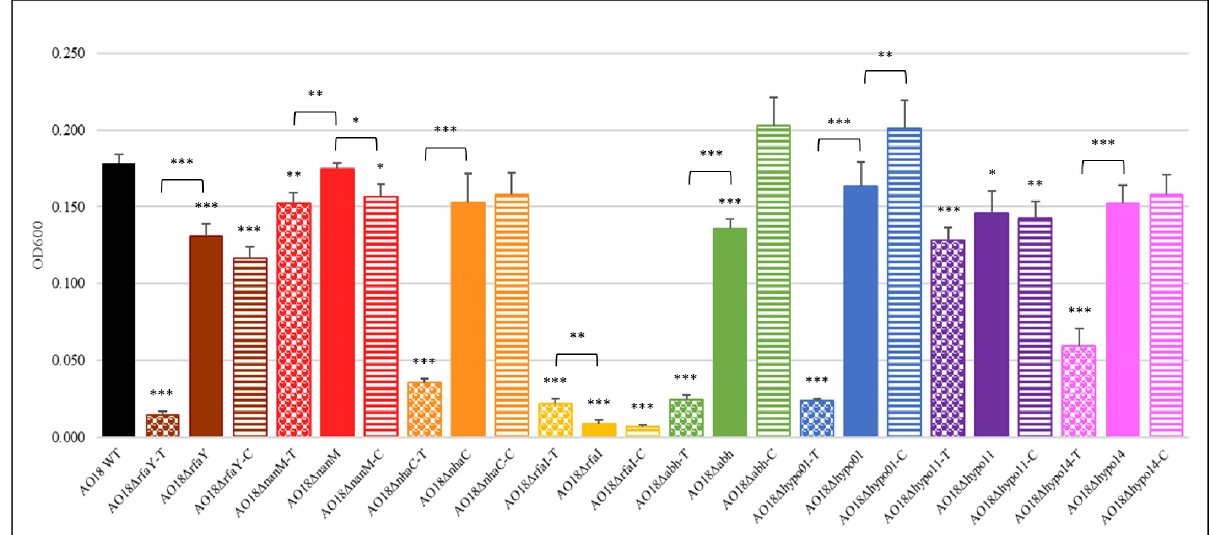
Fig 3. Biofilm production of all the strains tested. The biofilm formation ability of the transposon mutants, isogenic mutants, and complemented mutants were compared to that of the APEC O18 wild type (AO18 WT). Each test strain was grown statically for 24 h in M63 minimal medium and then evaluated for its biofilm formation ability using crystal violet assays. Each assay was performed with eight technical replicates on three separate days, and the absorbance data was averaged. Asterisks ( � ) above individual bars indicate a significant difference between that strain and AO18 WT, whereas asterisks above brackets joining two columns indicate significant difference between those two strains ( � p < 0.05, �� p < 0.01, ��� p < 0.001).